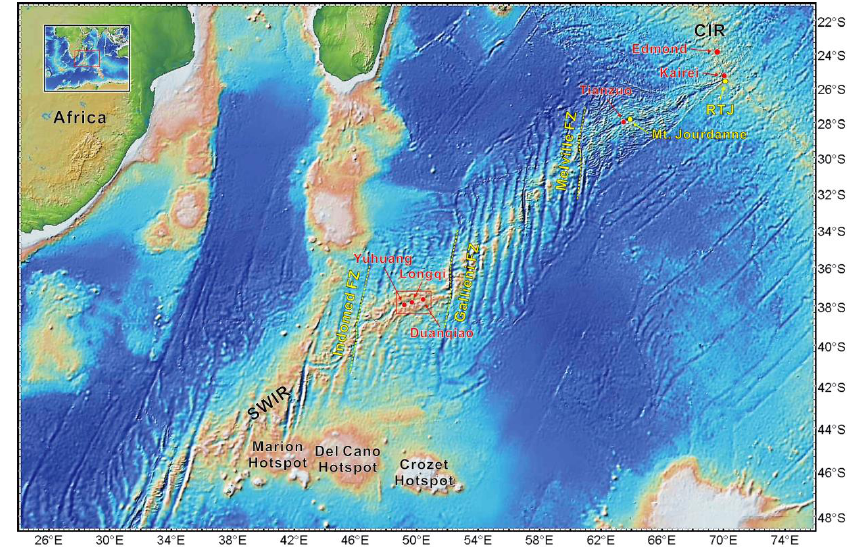
Figure 1. Figure 1. Location map of our study area on the Southwest Indian Ridge (between the Indomed and Gallieni fracture zones (FZs)) as well as the Central Indian Ridge (CIR) north of the Rodriguez Triple Junction (RTJ). Inset shows regional setting of the ultraslow-spreading SWIR. For more detailed bathymetry and topography data on each of these six hydrothermal fields (marked with red circles), please see the previously published literature